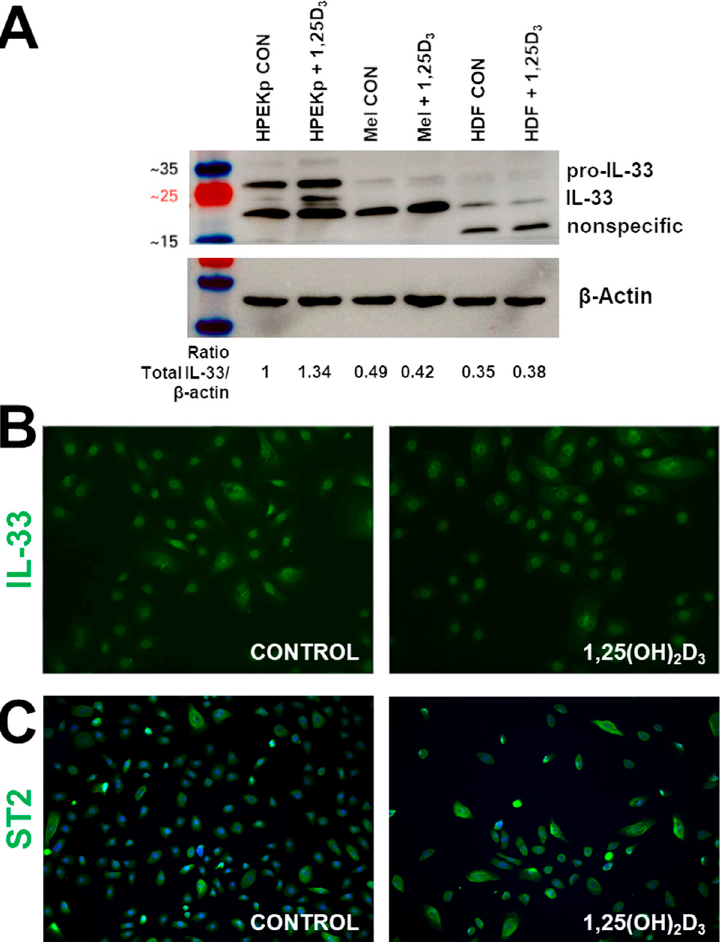
Figure 2. Vitamin D modulates the IL-33 and ST2 protein levels in keratinocytes. Keratinocytes were exposed to 100nM 1,25(OH)2D3 for 24 h. ( A ) Western blot of IL-33. The cumulative intensity of each band was quantified by densitometry analysis. The ratio of total IL-33 (pro-IL-33 and IL-33)/ β -actin was shown below the blots. ( B , C ) Representative images of IF of HPEKp cells. A total of twenty-four hours after vitamin D stimulation, HPEKp were stained with antibodies against IL-33 ( B ) and ST2 ( C ). Magnification—200×.